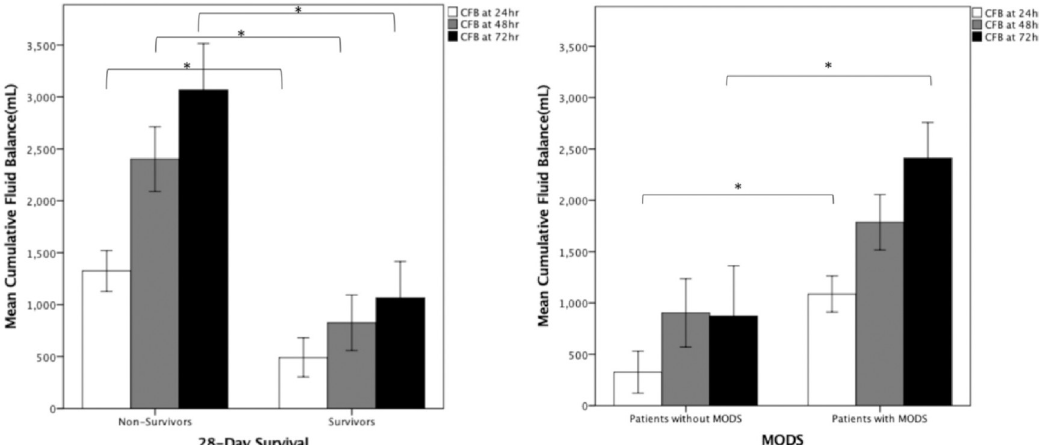
Fig 2. Relationship between cumulative fluid balance, MODS, and 28-day survival. (A) Cumulative fluid balances were significantly higher in non-survivors than in survivors of septic shock on 24 hr (open bar), 48 hr (gray bar), and 72 hr (black bar) ( � indicates p < 0.05); (B) Cumulative fluid balances were higher in patients with multi-organ dysfunction syndrome (MODS) than patients without MODS only on 24 hr (open bar) and 72 hr (black bar) ( p = 0.035) but not on 48 hr (gray bar) of septic shock ( � indicates p < 0.05) (data expressed as mean ±